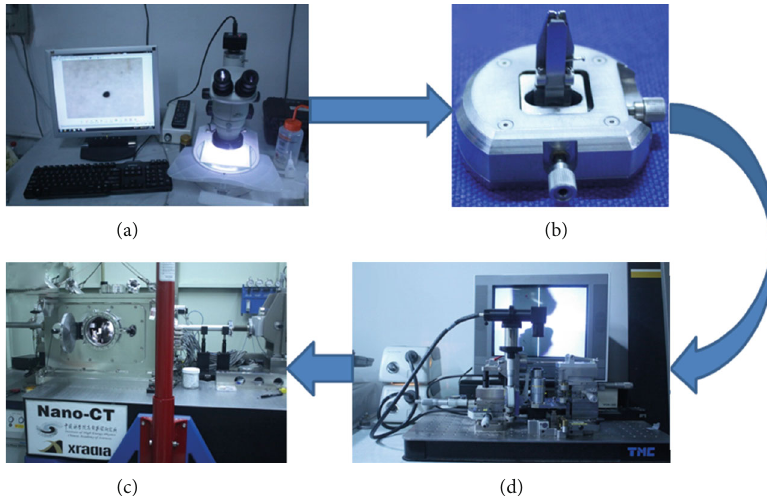
Figure 1: Photographs of the instruments for synchrotron radiation nano-CT imaging. (a) Instruments for placing the sample particle on the tip of a pin. (b) Sample turntable for clipping the pin. (c) Transmission X-ray microscopy (TXM) instrument. (d) Instruments for mounting gold particle on the